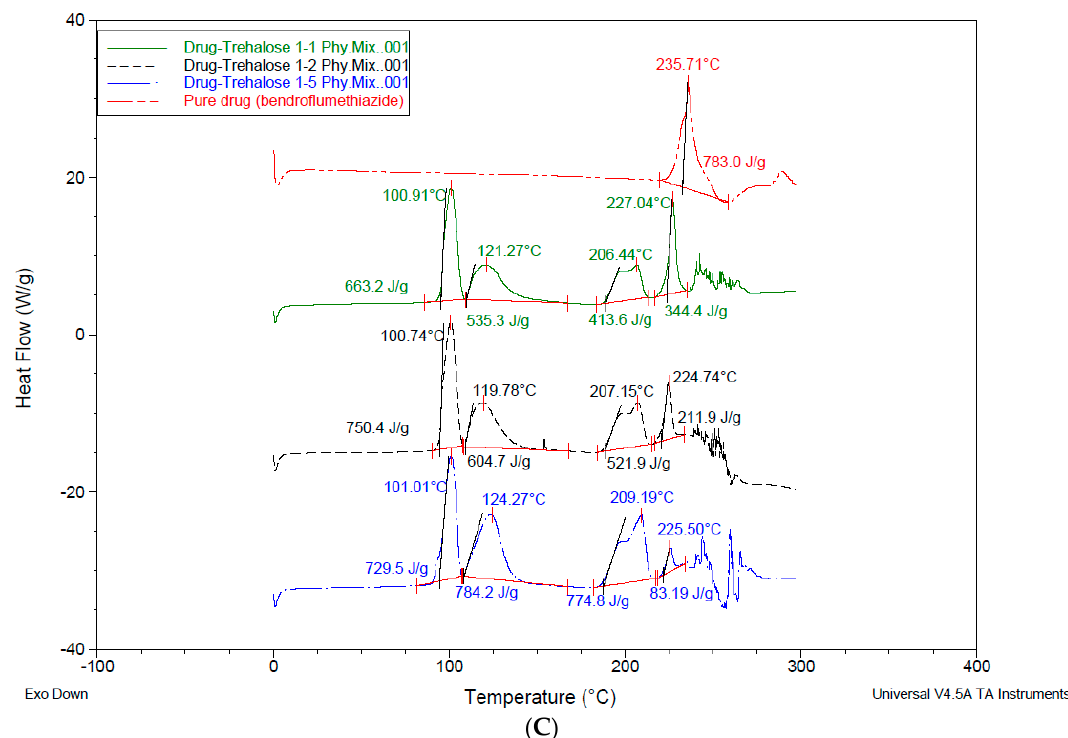
Figure 7. Differential Scanning Calorimetry (DSC) data for physically mixed drug with excipients.